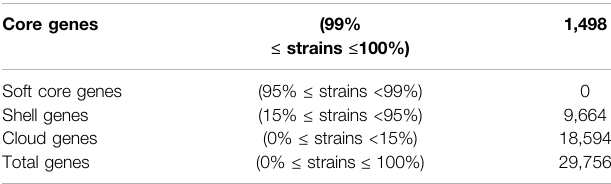
( Supplementary Table S1 )weredeterminedusingRoary(Pageet